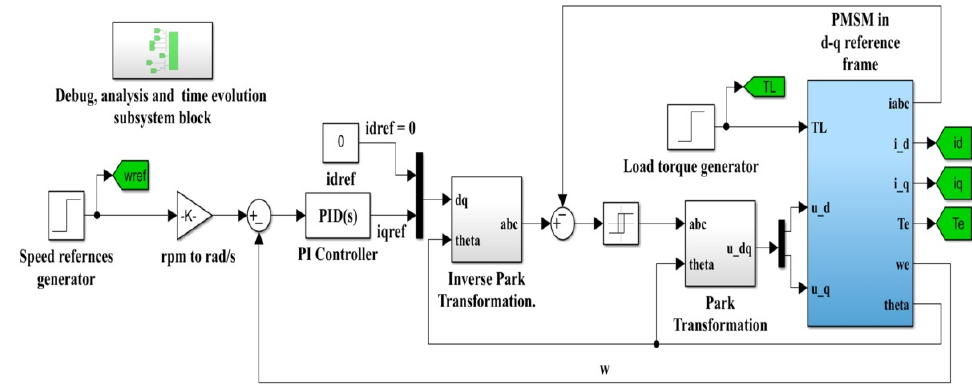
Figure 2. Simulink implementation for PMSM control system based on FOC-type strategy. Usually, the controllers of the two inner current control loops and the controller of the outer PMSM rotor speed control loop are of PI with nominal parameters as given in Table 1.